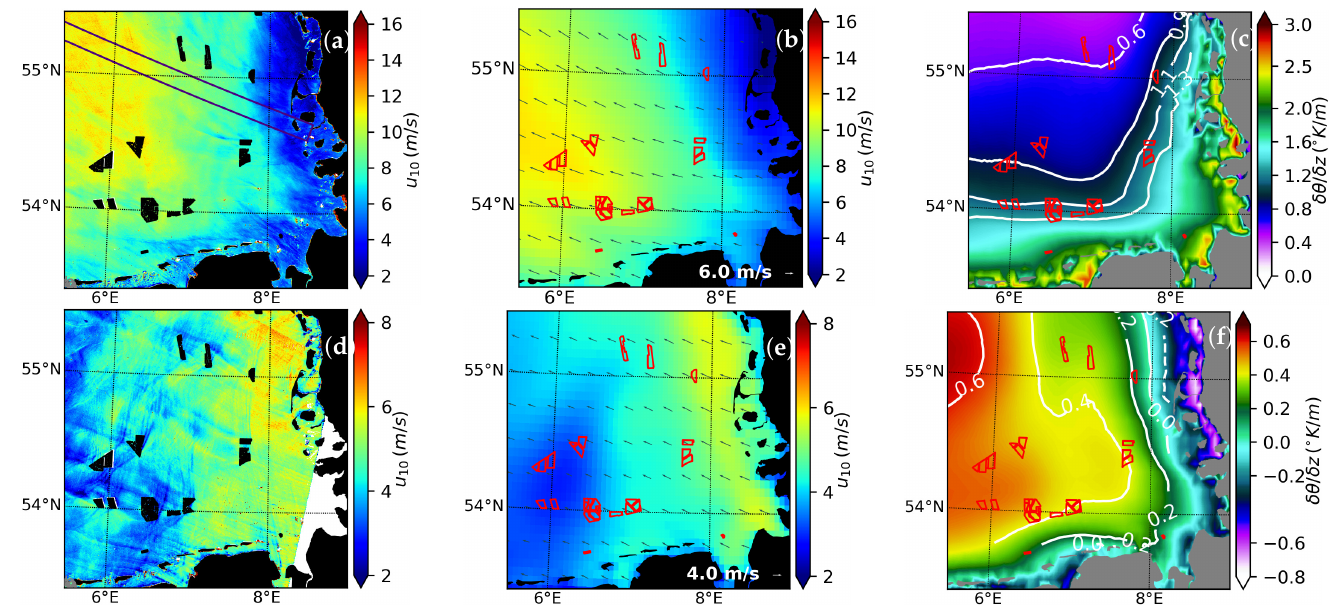
Figure 6. ( a – c ): 10 m wind speed from SAR on 6 April 2018 at 17:16UTC ( a ), DWD colocated 10 m wind ( b ), and thermal stability from DWD ( b ). ( c – e ): 10 m wind speed on 25 August 2019 around 05:48UTC from SAR ( d ), colocated wind and thermal stability from DWD, respectively, in ( e , f ). The rectangular purple box represents the transect “Ref” in an area without any influence of atmospheric wakes. Red polygons indicate wind farm